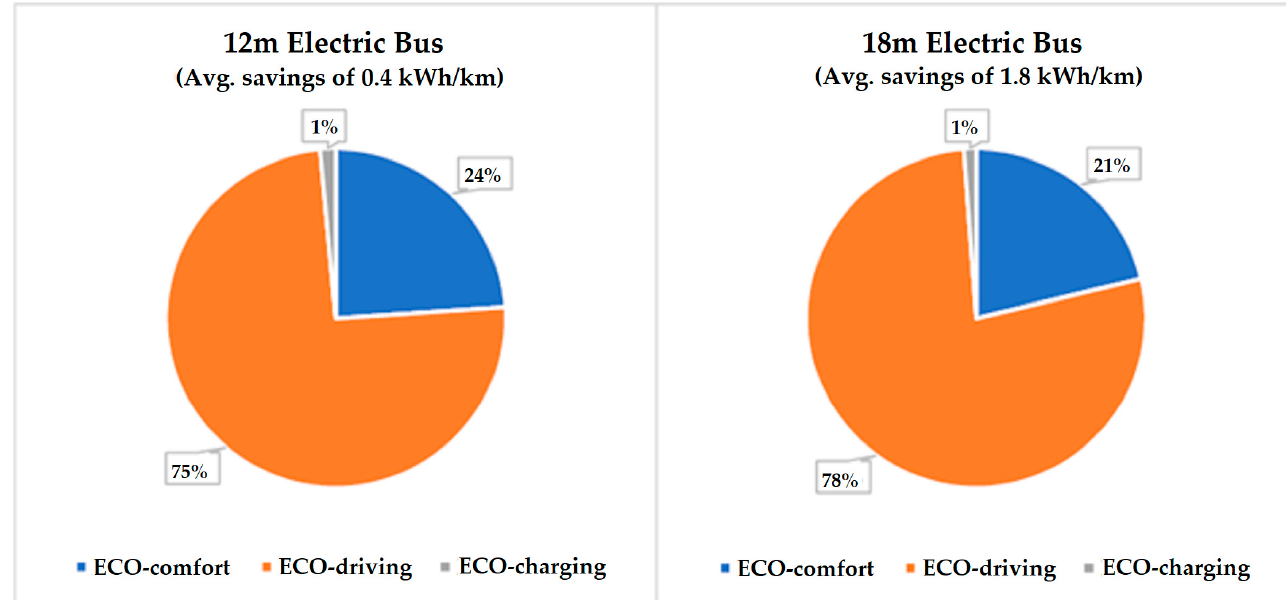
Figure 5. Breakdown of energy savings due to ECO ‐ features for 12 m and 18 m electric bus.